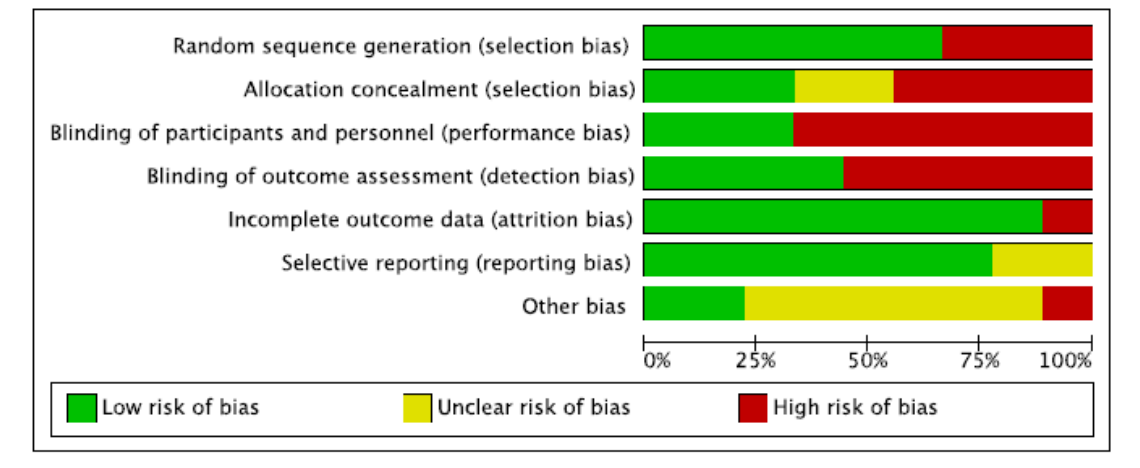
Figure 3. Risk of bias